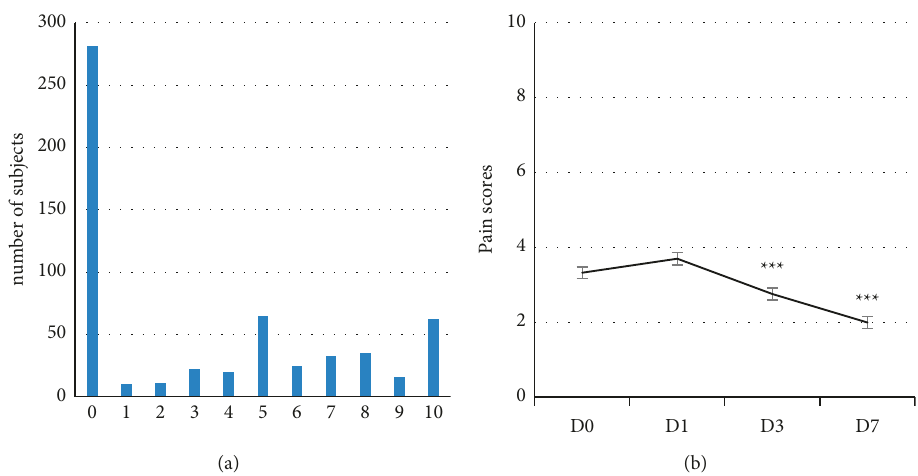
Figure 5: Anxiety. (a) Distribution of anxiety scores on D0, self-evaluated on a [0–10] numeric rating scale. (b) Evolution of anxiety scores from D0 to D7. A significant decrease is observed between baseline on D3 and D7 (ANOVA, Dunn’s test, p < 0 .